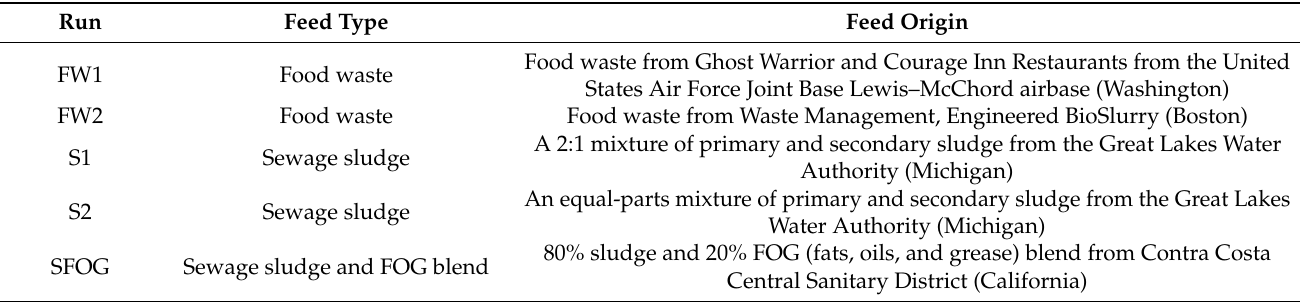
Table 1. Feed type and source utilized in each wet-waste continuous flow HTL run.